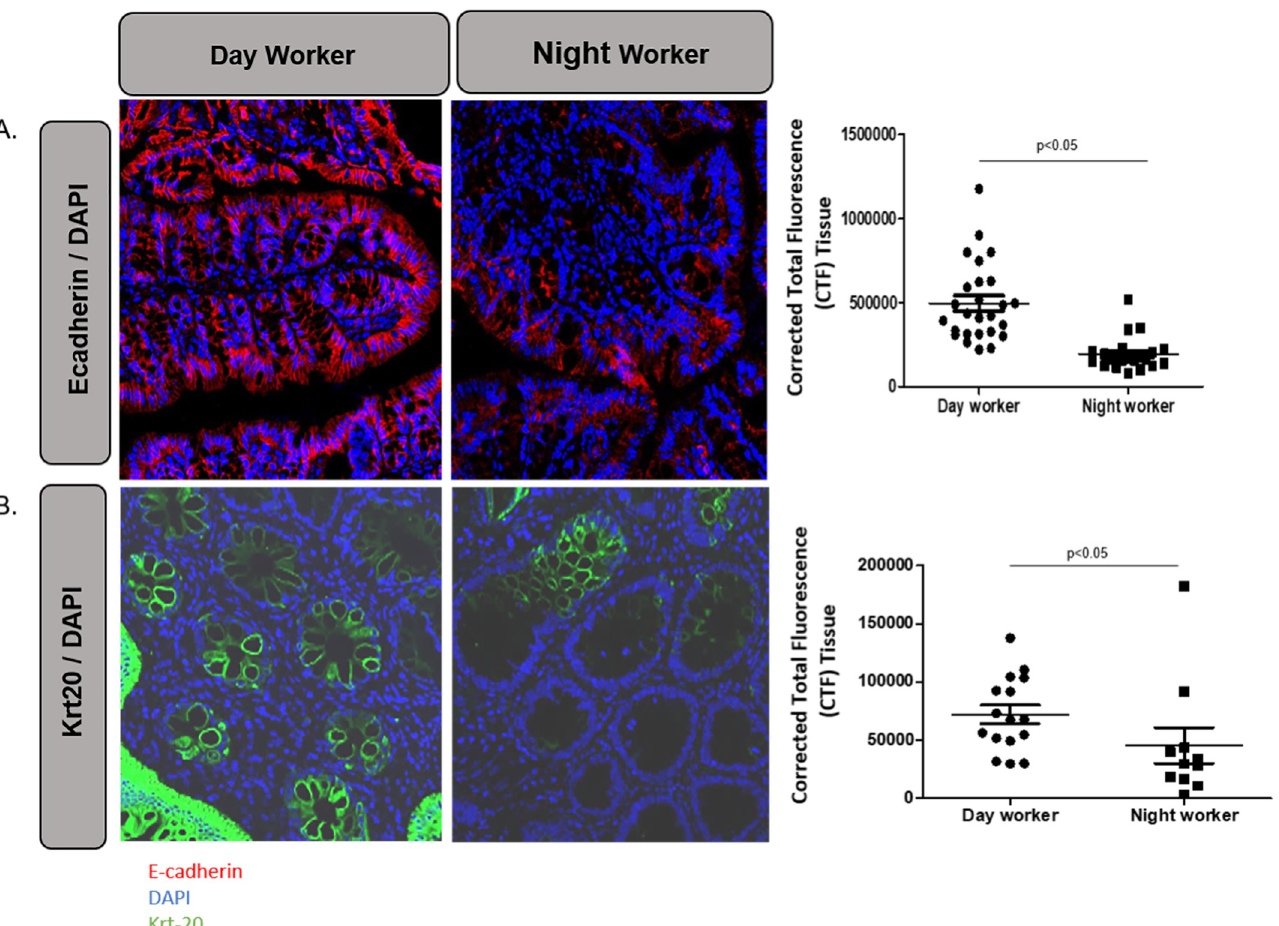
Fig 5. Colon tissue of a night shift worker exhibits loss of AJC permeability protein E-cadherin and Krt-20 proteins vs. a day worker’s colon tissue. Colonic biopsy tissues from a Night shift (shifted) worker and a day worker nurse were assessed for AJC protein E-cadherin and cytoskeletal protein Cytokeratin 20 (Krt- 20). with IF microscopy as described in Methods. (A) E-cadherin levels were lower in the night shift worker compared to the day worker (p = 0.001). (B) Krt-20 levels were lower in the night shift worker compared to the day worker as well (p = 0.011). Data points are random field values for each sample.